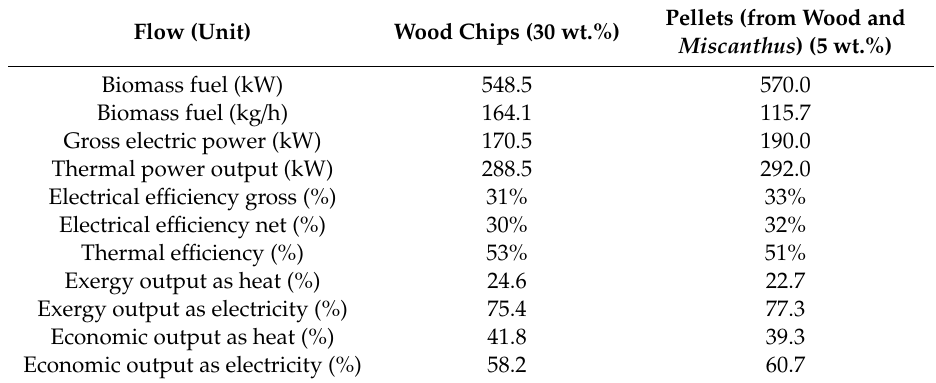
Table 2. Characteristics of the small scale HBP technology (8000 h of operations per year). Modeled